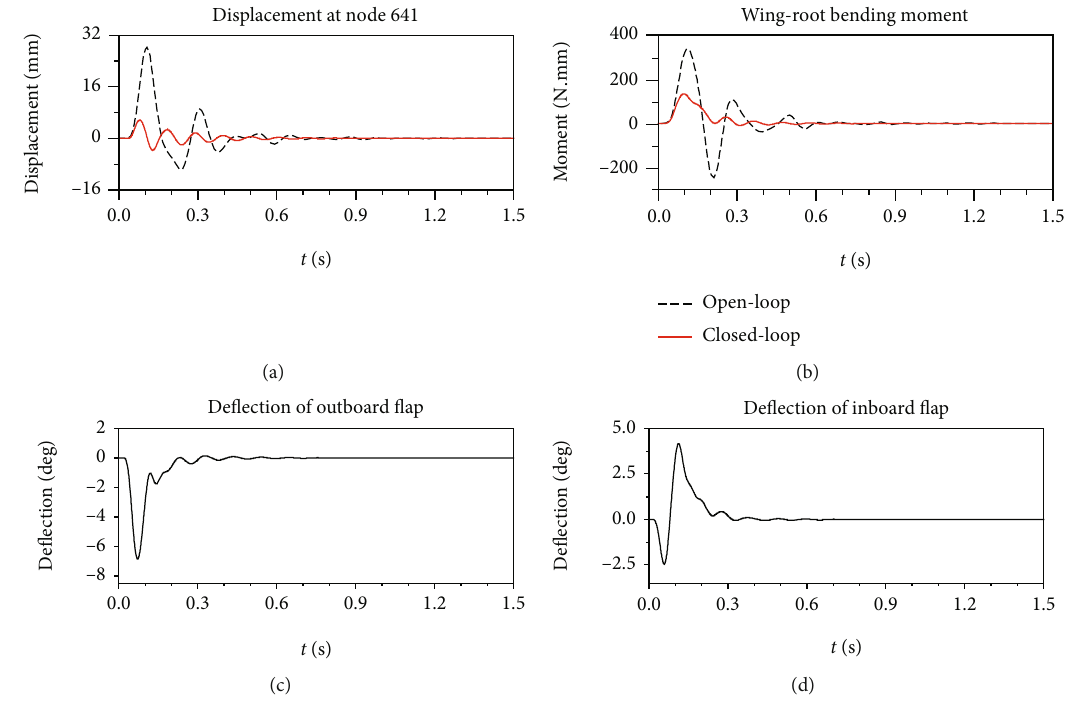
∞ = 30 m/s M fl ap de fl ection ( δ ) in discrete n ), wing-root bending moment ( x ), and outboard